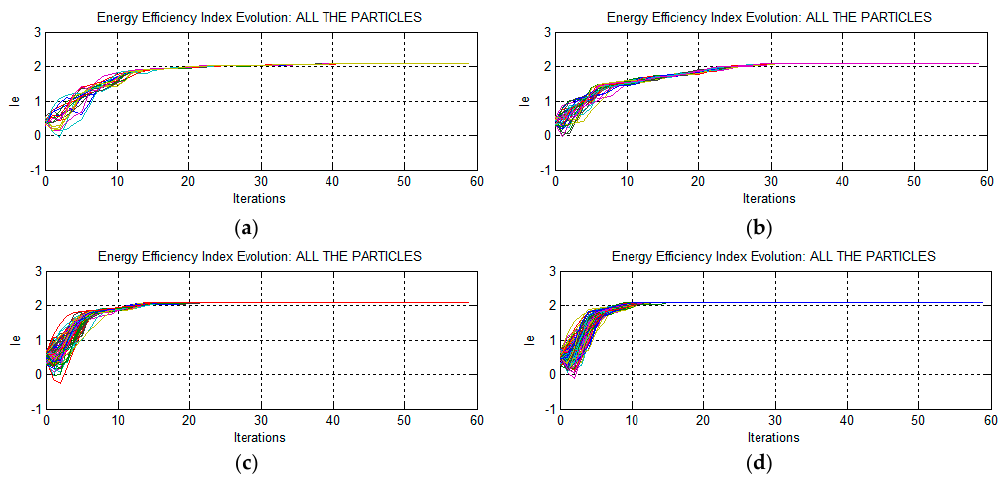
Figure 2. Energy efficiency index evolution for ( a ) 20; ( b ) 40; ( c ) 80 and ( d ) 120 particles.